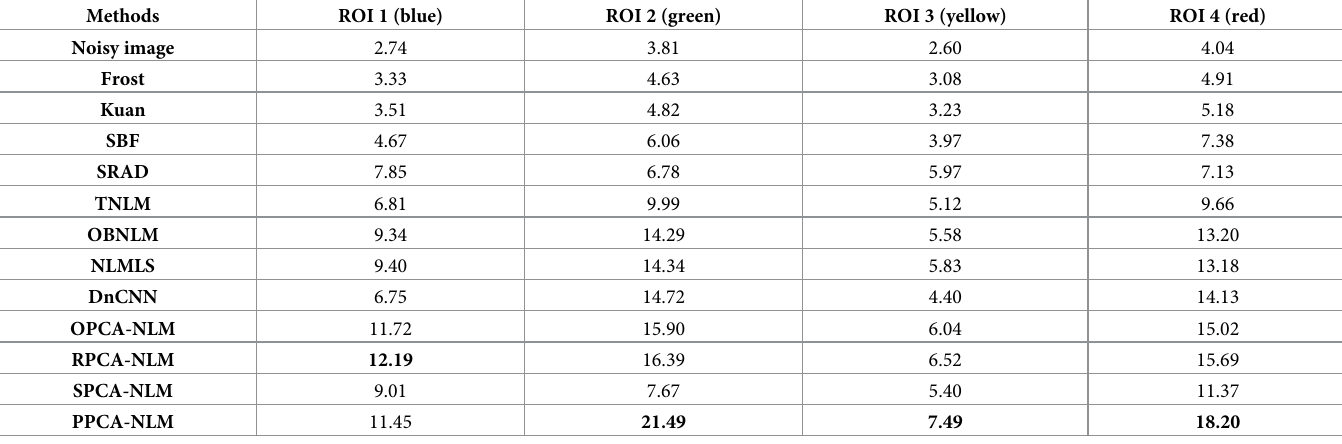
Table 4. The CNR values of four ROIs on the simulated ultrasound image.